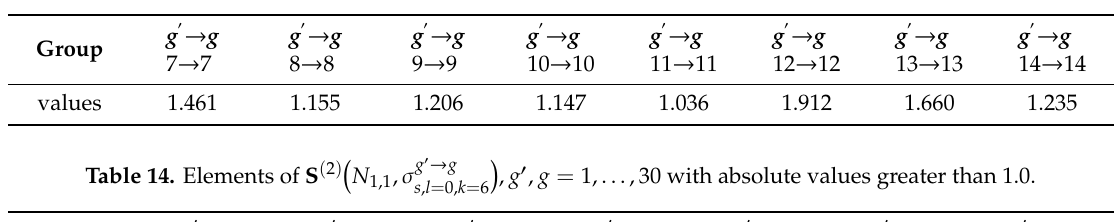
(cid:16) (cid:17) (cid:48) → g N 1,1 , σ g , g (cid:48) , g = 1, ... ,30 with absolute values greater than 1.0. s , l = 0, k = 1